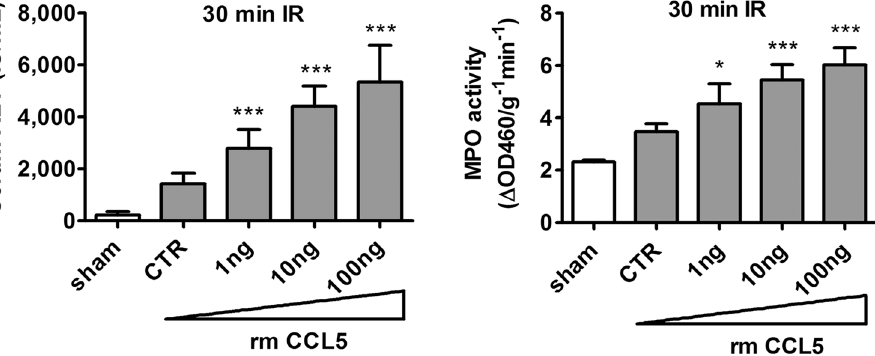
Figure 3. CCL5 introduction aggravated inflammatory hepatic IRI. C57BL/6C mice were subjected to 30 minutes of ischemia to allow for observation of aggravation of inflammatory injury in viable animals. Mice were dosed with vehicle control buffer or rmCCL5 in escalating doses (0, 1, 10 and 100 ng per animal) via jugular vein immediately after reperfusion. Mice were sacrificed at 24 hours after reperfusion. The serum ALT and tissue MPO activities increased in a dose-dependent manner (Mean ± SD, n = 8). CTR, control. * p < 0.05; *** p <